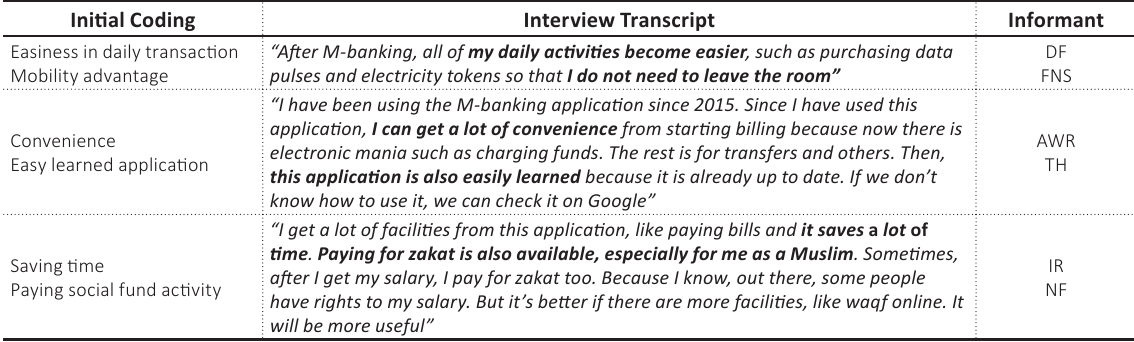
Table 2. Coding a positive impact based on interview data